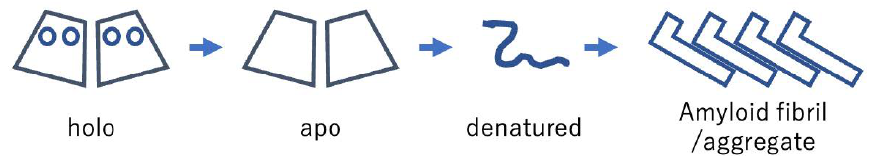
Figure 5. Schematic representation of denaturation and aggregation of cSOD1.